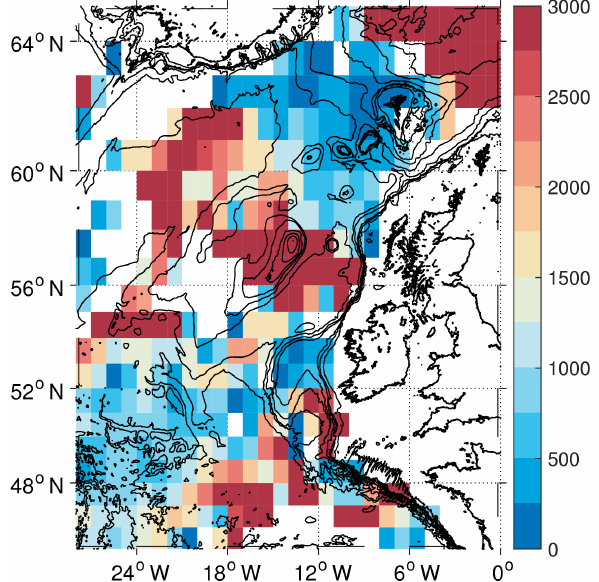
Figure 5. The depth scale H of Eq. (7), predicted from the merid- ional gradients of density and sea surface height; H is set to the local water depth, where H exceeds that depth; white areas inside the bold black contour indicate where H is negative